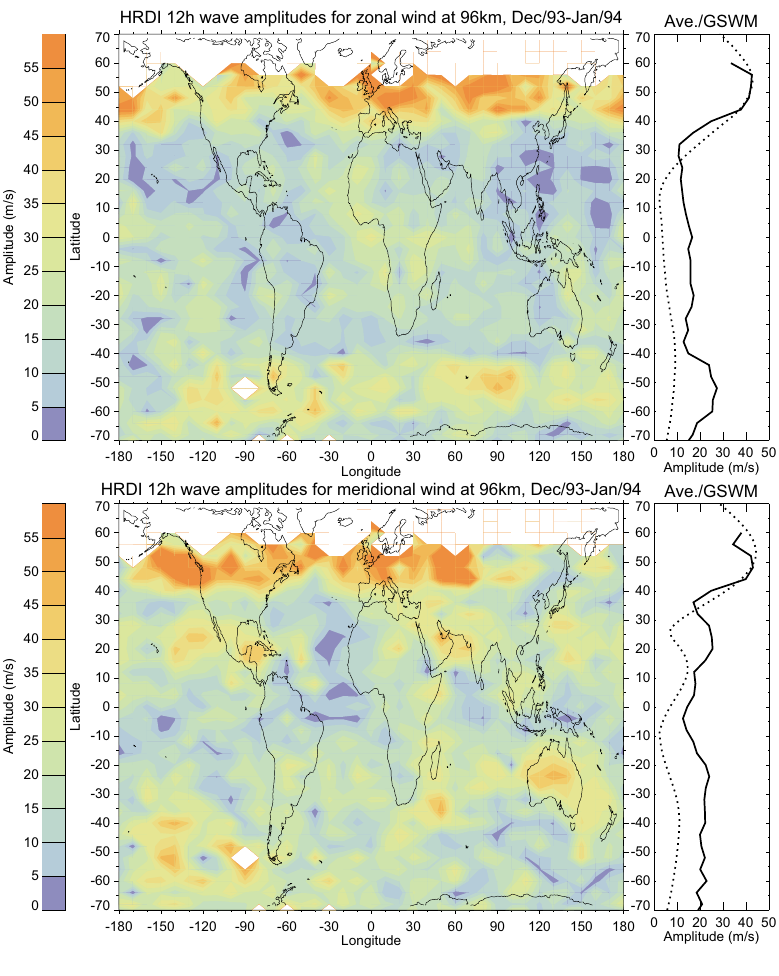
Fig. 9. Contoured plots of 12-h tidal amplitudes for December 1993– January 1994 from HRDI. The longi- tudinal averages are to the right (solid line), and also the GSWM-2000 values